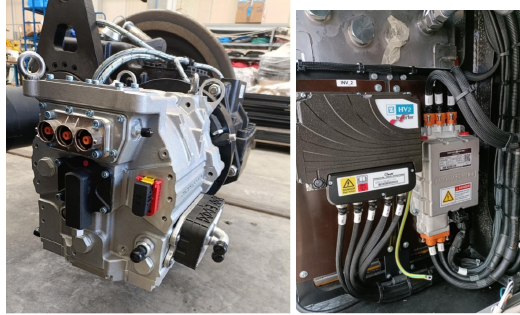
Figure 9. The electrical motor and traction inverter. Table 3. Parameters of the selected